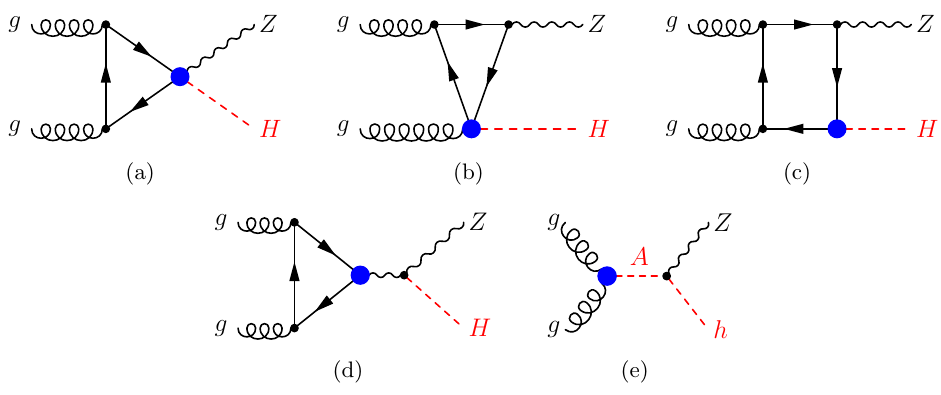
Figure 14 . Sample Feynman diagrams for contributions to gg ! ZH through dimension-6 oper- ators. The Feynman diagrams (a), (c) and (d) can alternatively have modi(cid:12)ed gq (cid:22) q (through L 4 ) or Zq (cid:22) q couplings (through L 1 ; 2 ; 3 ). (e) shows the contribution of the dimension-5 operator L 6 for gg ! Zh in a 2HDM /the MSSM